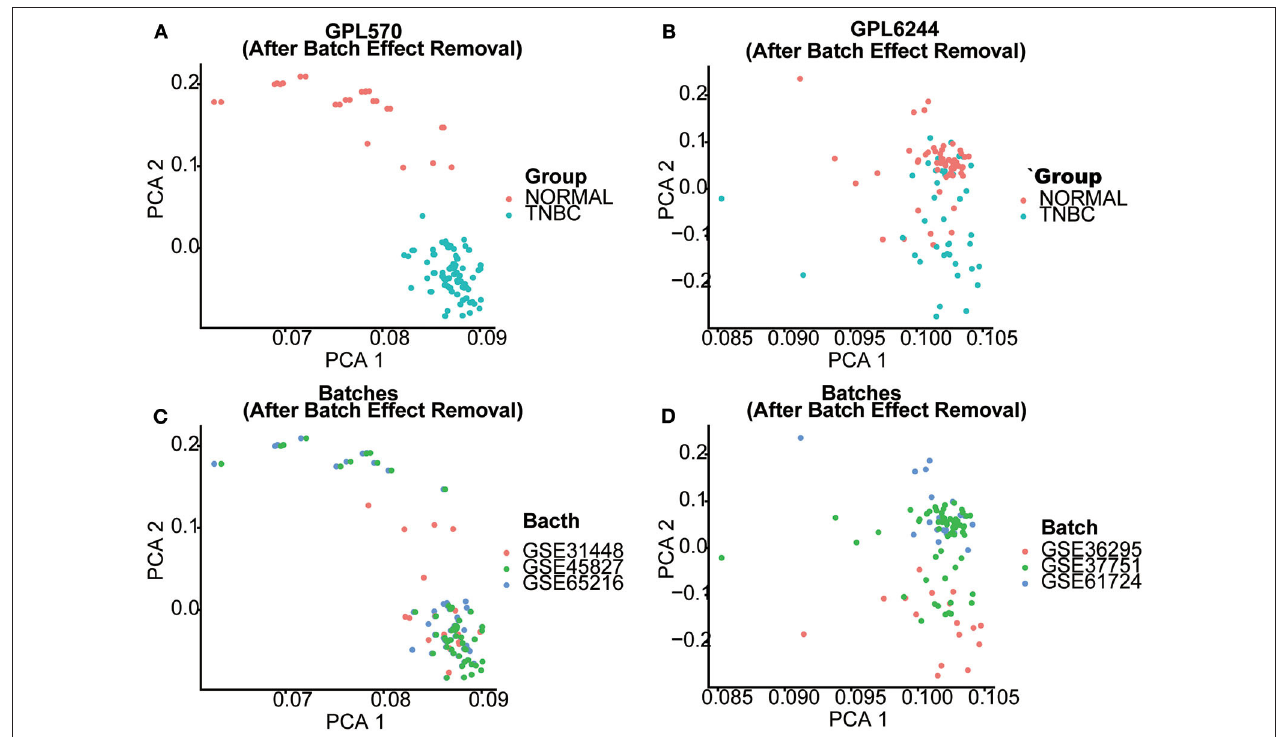
FIGURE 1 | Batch effect correction of GPL570- and GPL6244-based datasets. The effectiveness of batch effect correction is demonstrated using a principal component analysis (PCA) plot. (A,B) The PCA plot of GPL570- and GPL6244-based datasets after batch effect correction. Red dots represent normal breast tissues, whereas blue dots represent triple-negative breast cancer (TNBC) samples. (C,D) PCA plots of the GPL570- and GPL6244-based datasets after batch effect correction. Samples from different GSE datasets are marked by their colors. After the batch effect correction, samples from different GSE datasets were mixed in the PCA plot, whereas normal breast tissues and TNBC samples were clearly separated from each other. This implies that the batch effect correction process was sufficient without reducing the difference between normal breast tissue and TNBC